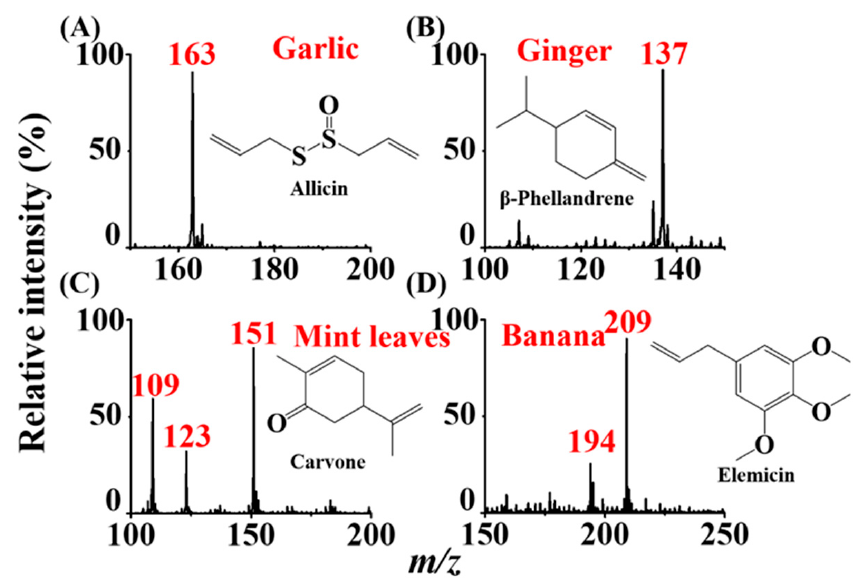
Figure 5. Detection of aroma molecules directly from plants including ( A ) garlic, ( B ) ginger, ( C ) mint leaves, and ( D ) bananas. The samples were placed near the titanium slab (0.3 cm × 0.3 cm) which was placed close to the inlet of the mass spectrometer with a distance of ~0.1 mm. The voltage set on the inlet of the mass spectrometer was − 4500